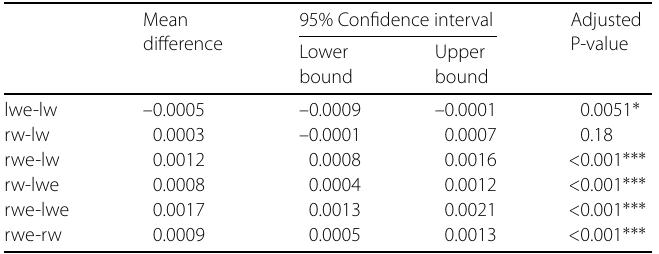
Table 20 ANOVA results to test for correlation of political orientation and extremity with text-based indicators of purity Degree of Sum of square Mean square F value Pr (> F ) freedom Political orientation 1 0.00000006 0.00000006 8.54 0.003 ∗ Political extremity 1 0 0.000000002 0.34 0.561 Residuals 19,997 0.0001138 0.000000007 –